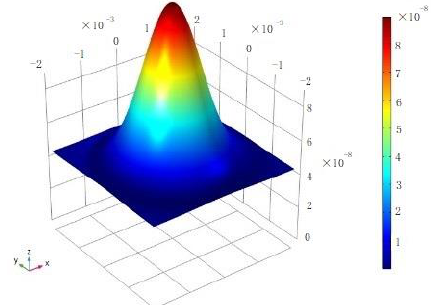
Figure 3. Heat source model.